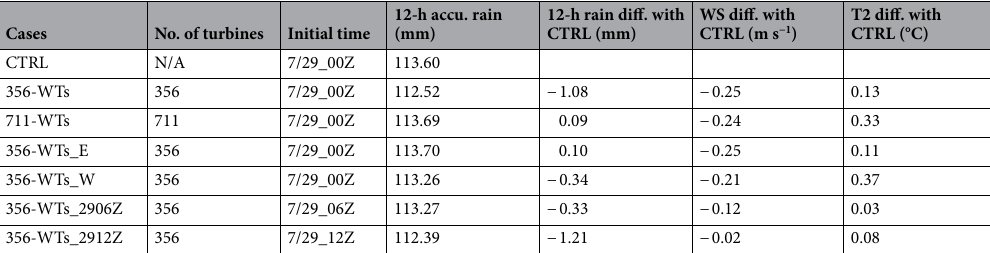
Table 1. Summary of simulation cases and the differences in accumulated precipitation, hub-height wind speed (WS), and 2-m temperature (T2) compared with that in CTRL over southern Taiwan (22.5–24.0°